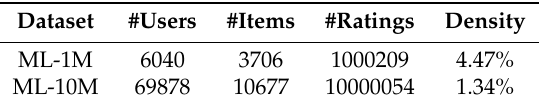
Table 1. Statistics of